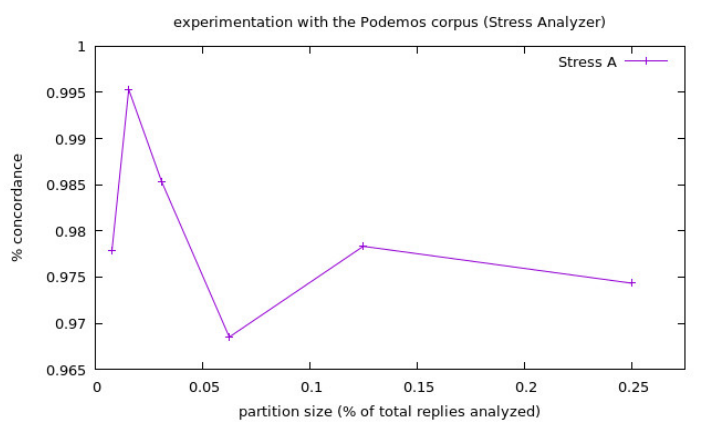
Figure 3. Results of the experiments with the corpora Podemos for the Stress